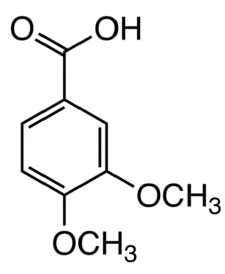
Figure 1. Chemical structure of veratric